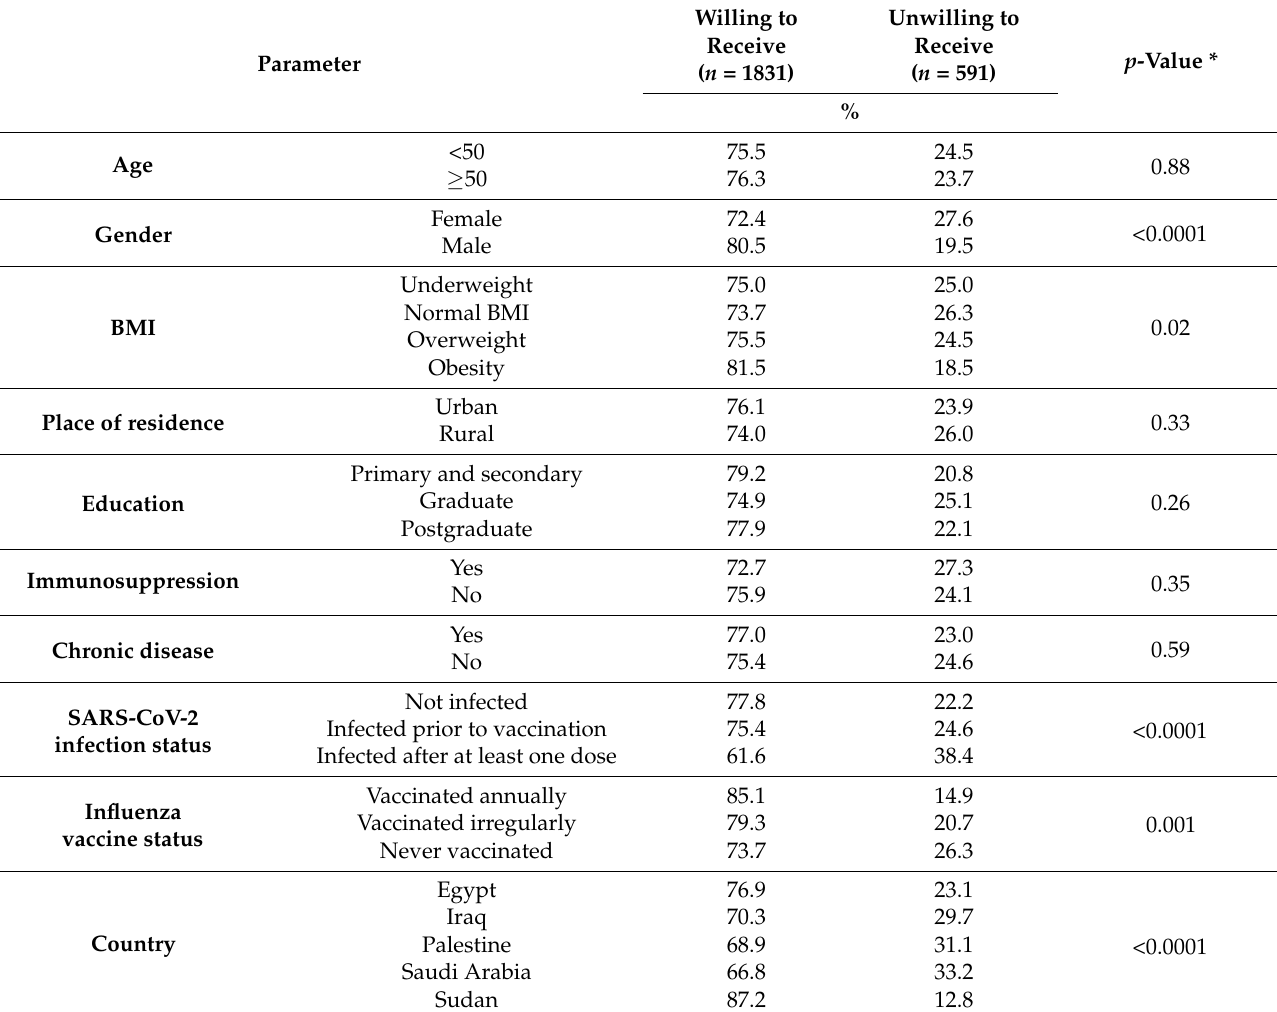
Table 2. The willingness and unwillingness to receive booster COVID-19 vaccine dose in several demographic groups ( n = 2422, excluding uncertain responses, n =